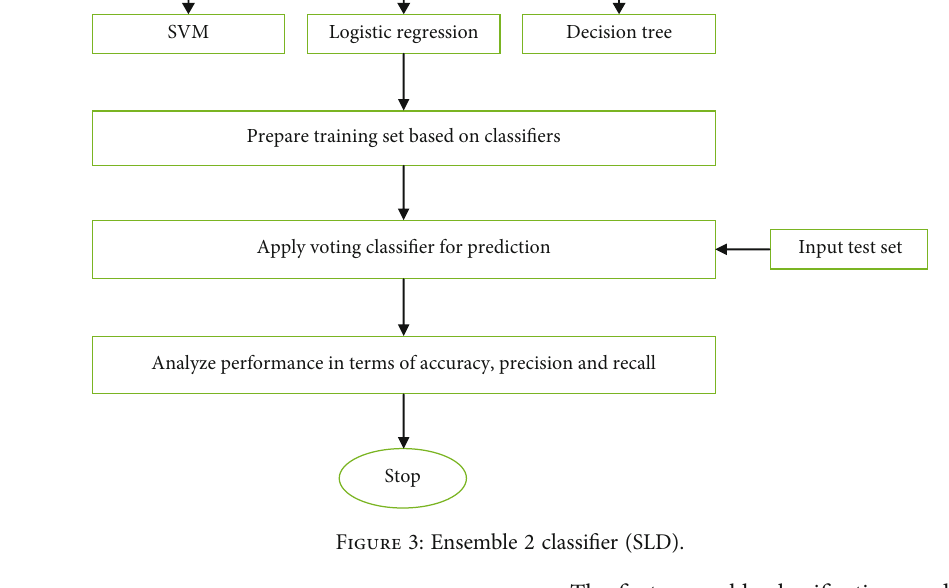
Figure 3: Ensemble 2 classi fi er